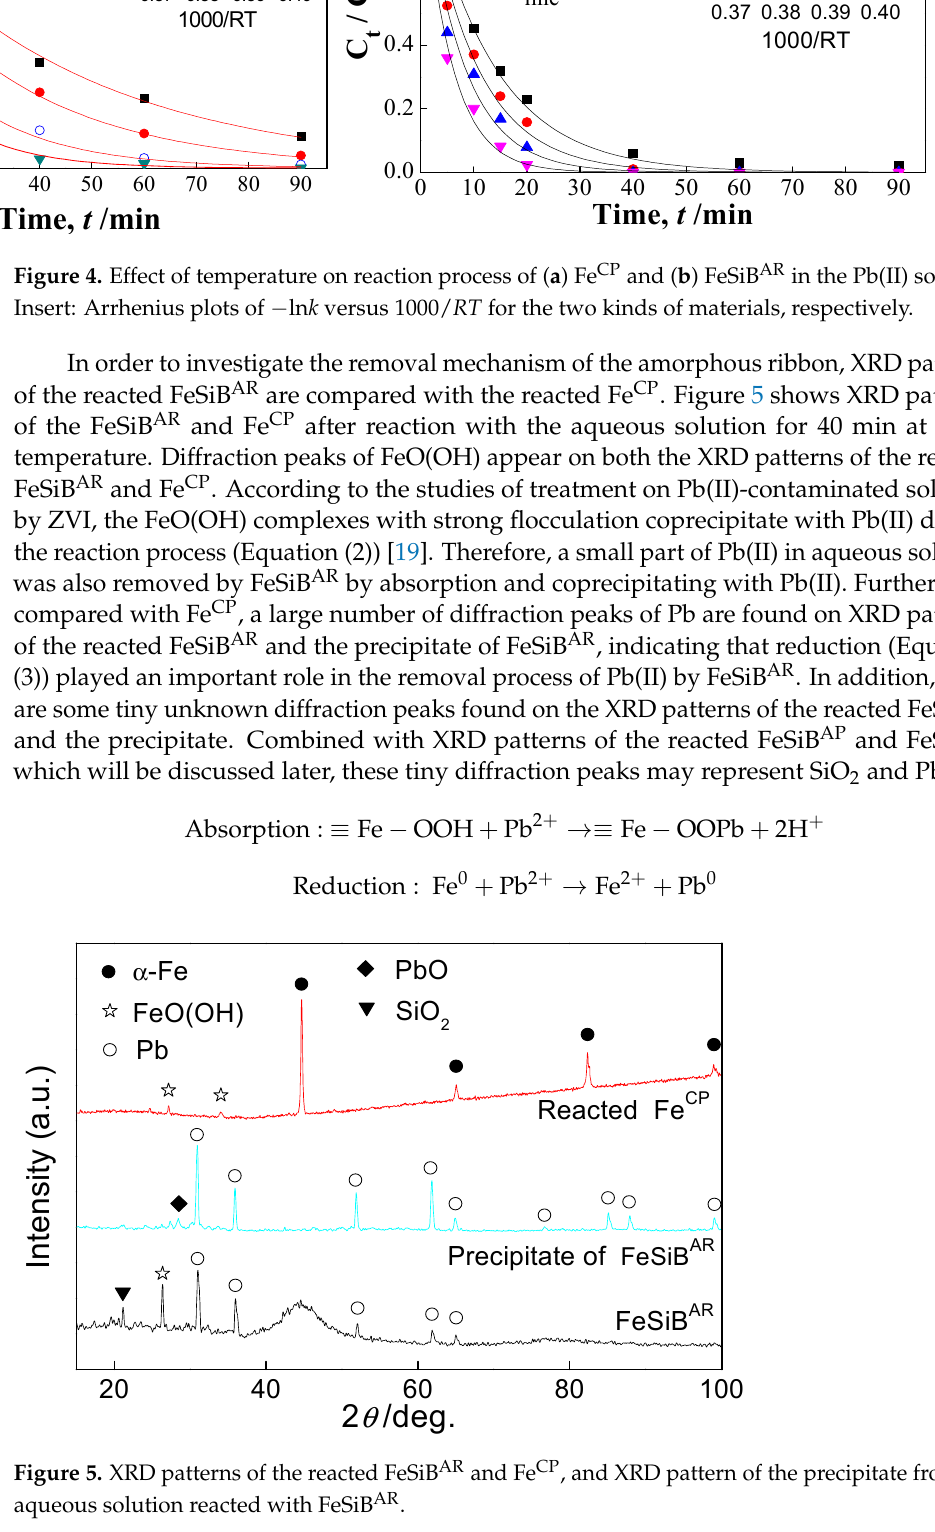
Figure 4. Effect of temperature on reaction process of ( a ) Fe CP and ( b ) FeSiB AR in the Pb(II) solution. Insert: Arrhenius plots of − ln k versus 1000/ RT for the two kinds of materials, respectively.